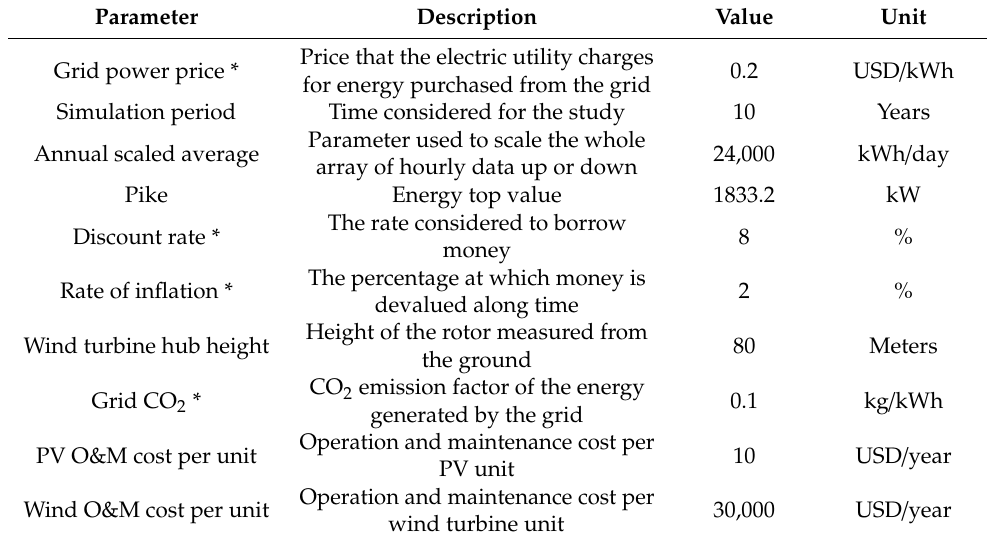
Figure 5. Seasonal profile of energy demand used in this study. Table 3. Di ff erent parameters requested by HOMER Pro ® for the specific economic and power calculations, where O&M means Operation & Maintenance and * indicates an estimated